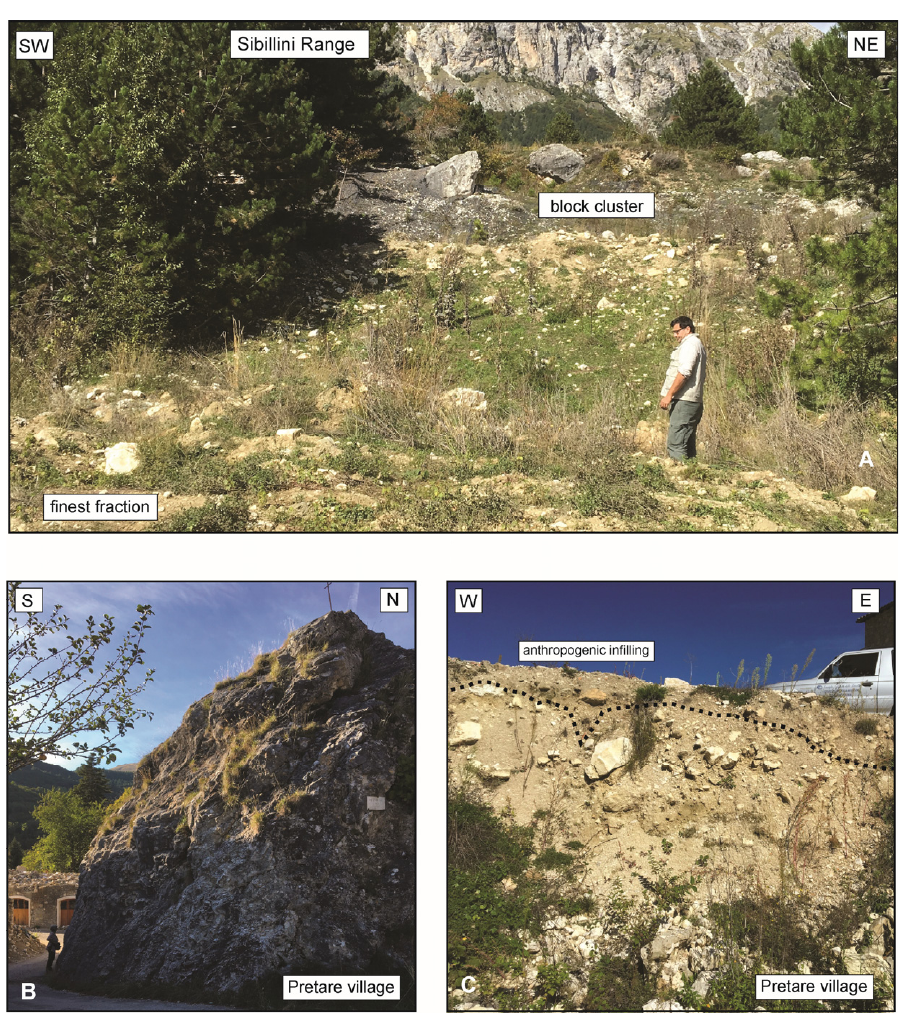
Figure 10. ( A ) Matrix-supported facies of the Pretare-Piedilama clastic deposits; ( B ) example of isolated mega-block; ( C ) carapace facies overlaying debris deposit.